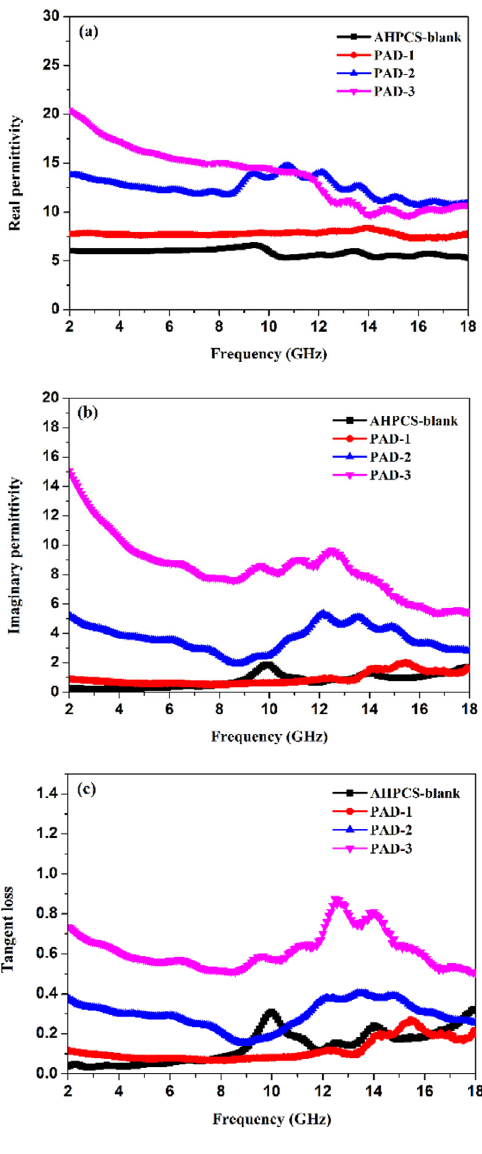
Fig. 8 (a) The real permittivity, (b) the imaginary permi- ttivity, and (c) the dielectric loss of AHPCS-blank, PAD-1, PAD-2, and PAD-3 derived ceramics annealed at 1600 ℃